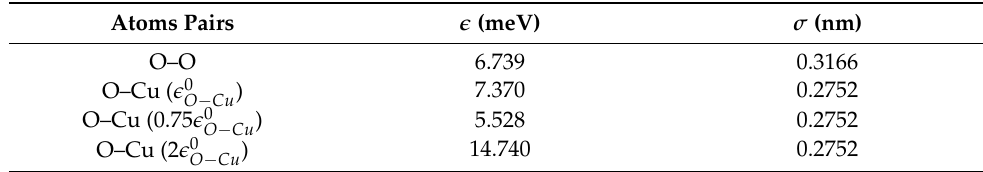
Figure 1. Initial structure of simulated system: ( a ) total model, ( b ) bottom section, ( c ) nanorough Surface − 1, and ( d ) nanorough Surface 1. Table 2. Parameters for L-J potential